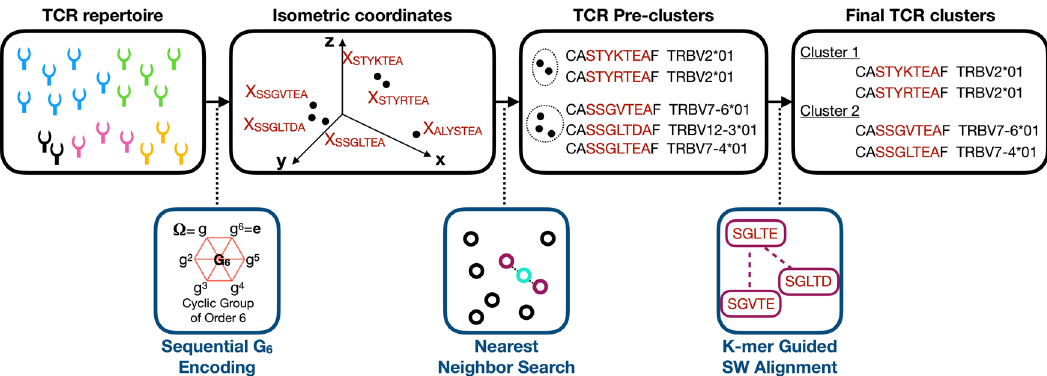
Fig. 1 Schematic illustration of GIANA. GIANA work fl ow. GIANA began with encoding of short CDR3 peptide sequences into numeric vectors through a sequence of unitary transformations. The transformation involves an element of 6 th order cyclic group. After encoding, each CDR3 sequence was projected to high-dimensional Euclidean space, allowing fast nearest neighbor search for clustering. Follow-up fi ltering steps were performed to match the TRBV gene alleles and remove pairs with low alignment